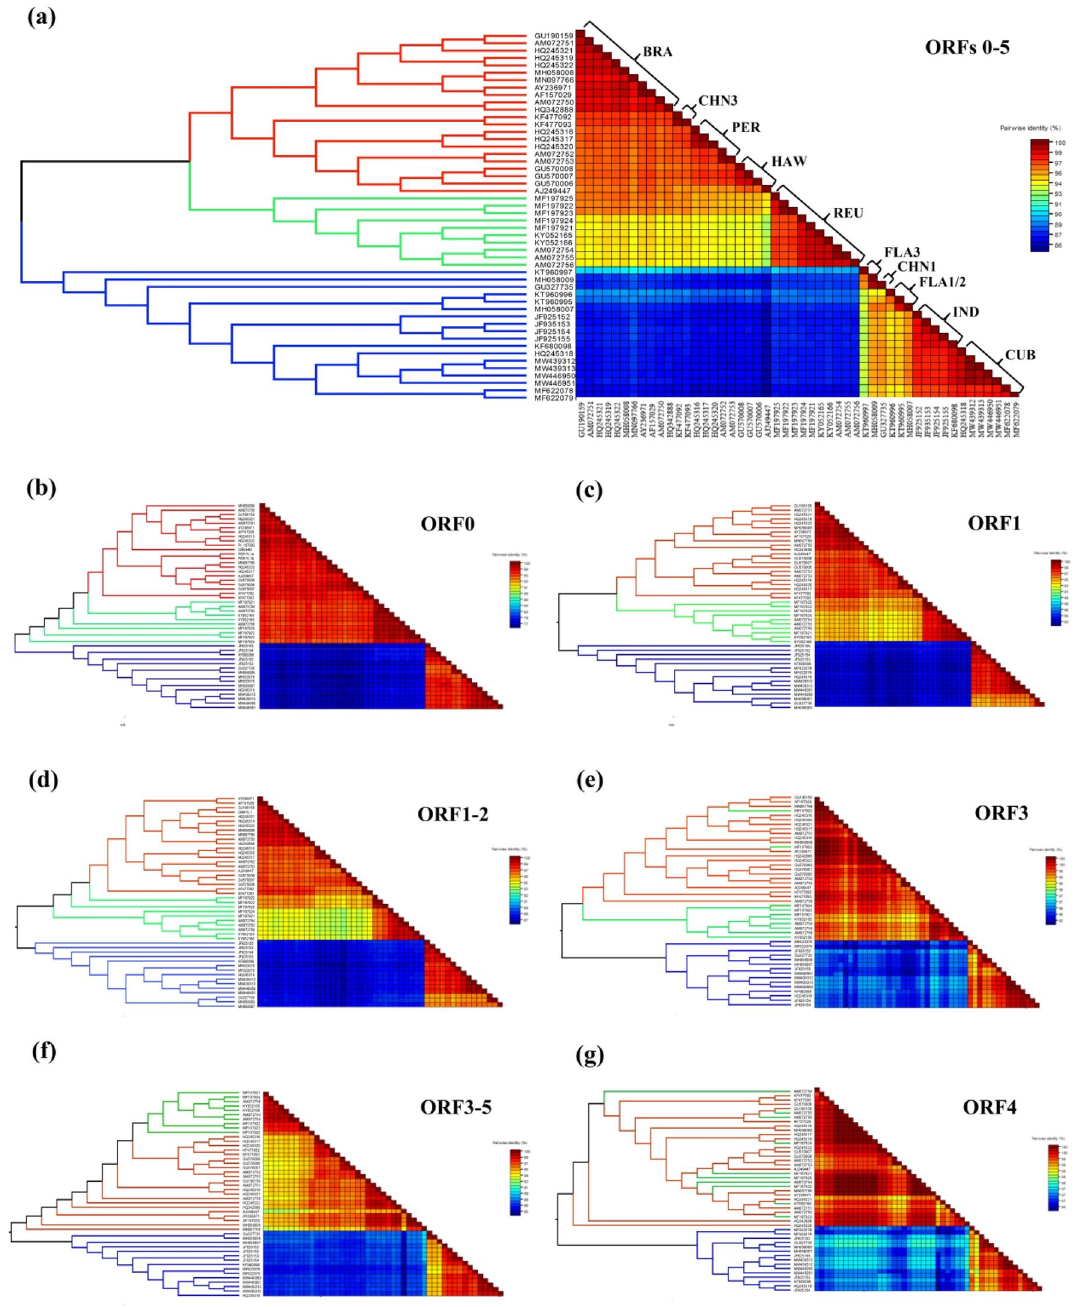
Figure 2. Maximum Likelihood phylogenetic trees (leaf panel) constructed by IQ-TREE v1.6.12 and pairwise identity matrixes (right panel) constructed by SDT v1.2 among SCYLV isolates. ( a ) Fifty nearly-complete genome sequences of SCYLV. ( b )–( g ) Six nucleotide sequences of ORF 0, ORF 1, ORF 1–2, ORF 3, ORF 4, and ORF 3–5 from 47 SCYLV isolates (Sorg1_1, Sorg2_2, and Sorg3_3 were excluded), respectively. The acronyms of each SCYLV genotype: BRA (Brazil), HAW (Hawaii), PER (Peru), CHN (China), REU (Reunion), FLA (Florida), IND (India), and CUB the other hand, the five aforementioned parameters were also calculated for pairwise comparison between the SCYLV phylogrouping subpopulations. These results demonstrated significantly high values of Ks*, Z*, and Snn statistics for each gene between SCYLV phylogrouping subpopulations (except for MP gene in the comparison of G1 versus G2 subpopulations), indicating that the isolates between most phylogrouping subpopulations had a very high genetic differentiation and infrequent gene flow (Fst > 0.33 and Nm < 1; Table S3).